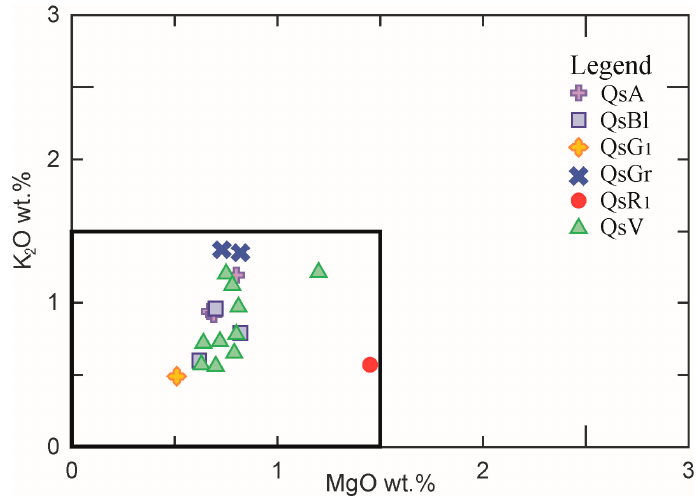
Figure 3. Binary diagram of MgO vs. K 2 O. The square area encloses the composition of natron glass. The samples analysed contain lead in variable concentrations, indeed, PbO contents vary from negligible to up to 17.49 wt.% (Table 2). The highest lead contents are detected in the yellow and red samples, showing, respectively PbO = 17.49 wt.% and 9.22 wt.%, and remarkable concentrations are also identified in some green tesserae (PbO varying from 1.12 to 6.91 wt.%). These results show